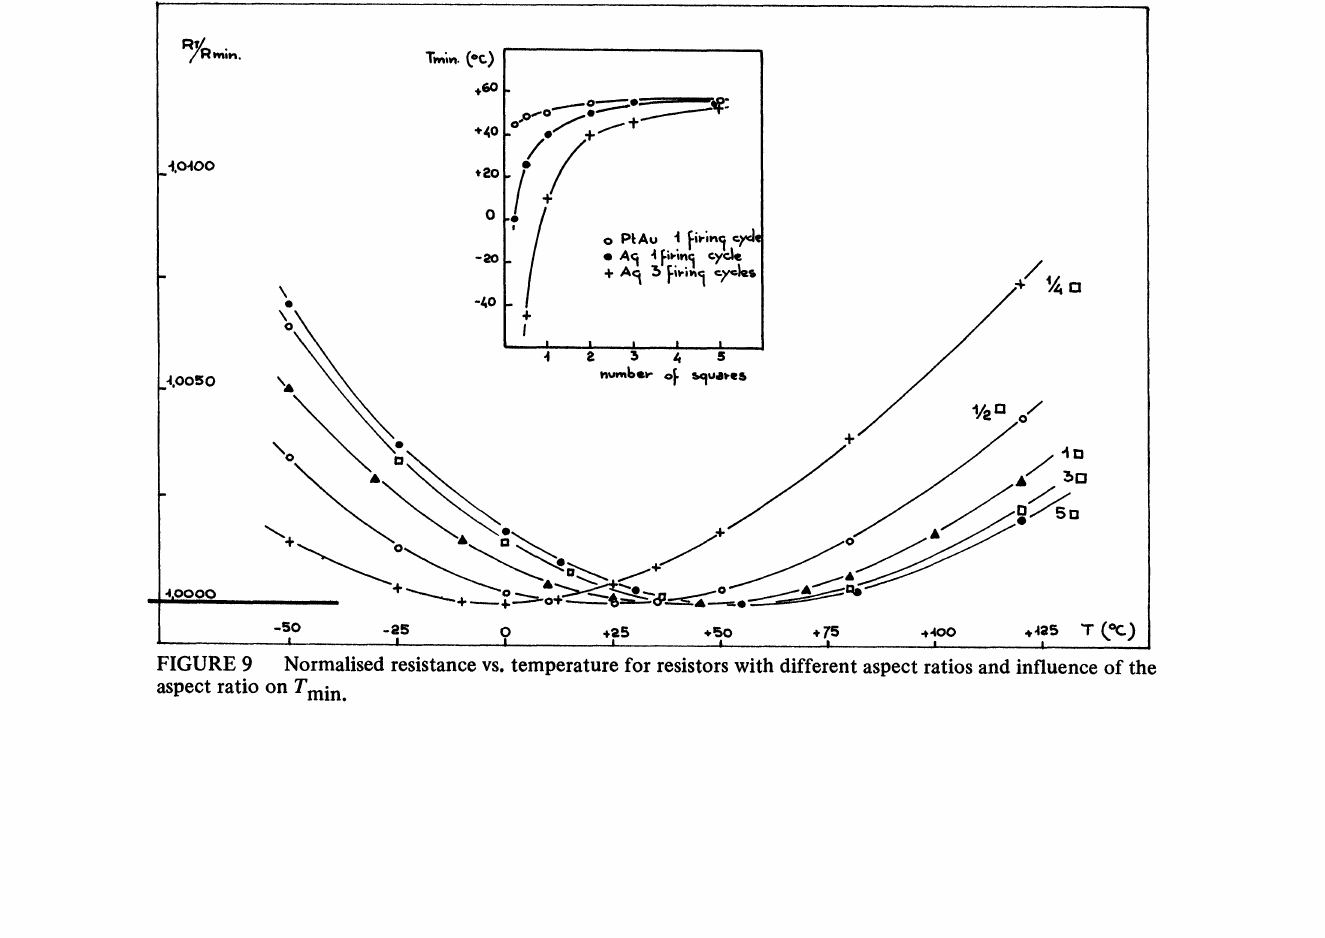
Measurements of trace conductance made on the same sample after successive firing cycles, and plot of the electrical diffusion length vs. number of firing cycles.